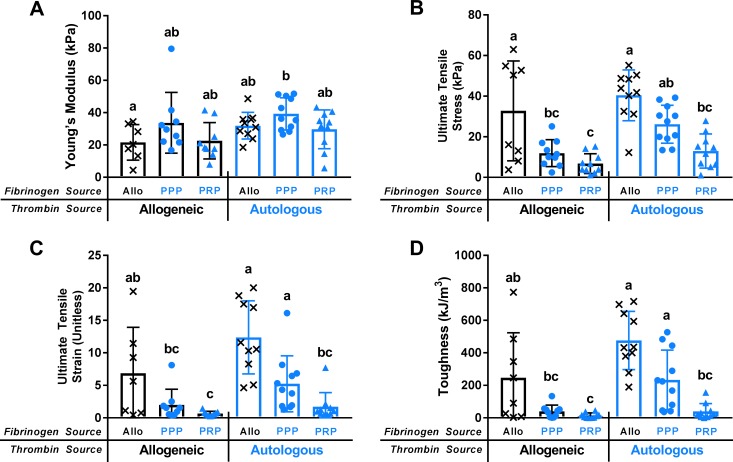
Young’s Modulus and failure properties of fibrin sealants.Young’s Modulus (A) and failure outcomes of ultimate tensile stress (B), ultimate tensile strain (unitless) (C), and toughness (D) for fibrin sealants. Thrombin source denoted by bar outline color (allogeneic: black; autologous: blue) and fibrinogen source by data point color and shape (x: allogeneic; circle: PPP; triangle: PRP). Fibrinogen sources on x-axis. Sealants with different letters were statistically significant.